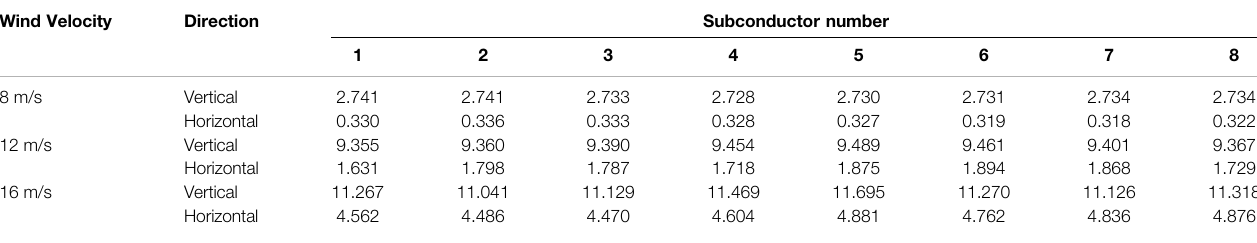
TABLE 5 | Vibration amplitude of each subconductor during line galloping under different wind velocities. Wind